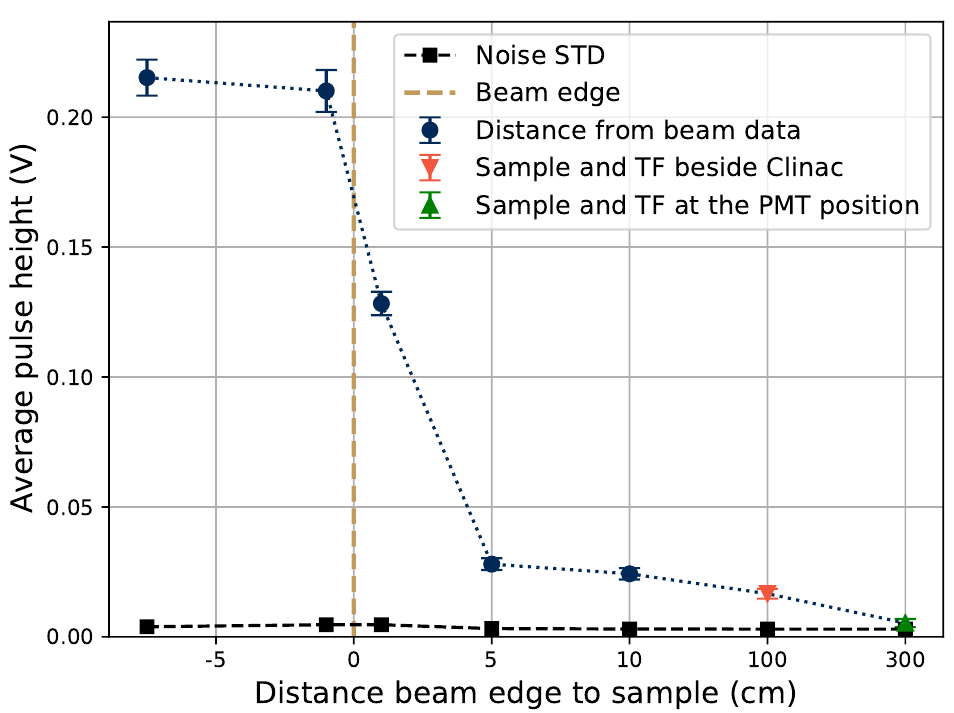
Figure 10. Pulse height as a function of the Gd-doped samples position relative to the edge of the electron beam. The beam spot was a square with 15-cm sides, and the point at − 7.5cm is taken in the beam center. At the point at a 300-cm distance, the sample was laying at a position beside the PMT and electronics. Electron bunches of 5 mGy/bunch at 20 Hz were used to produce this data.